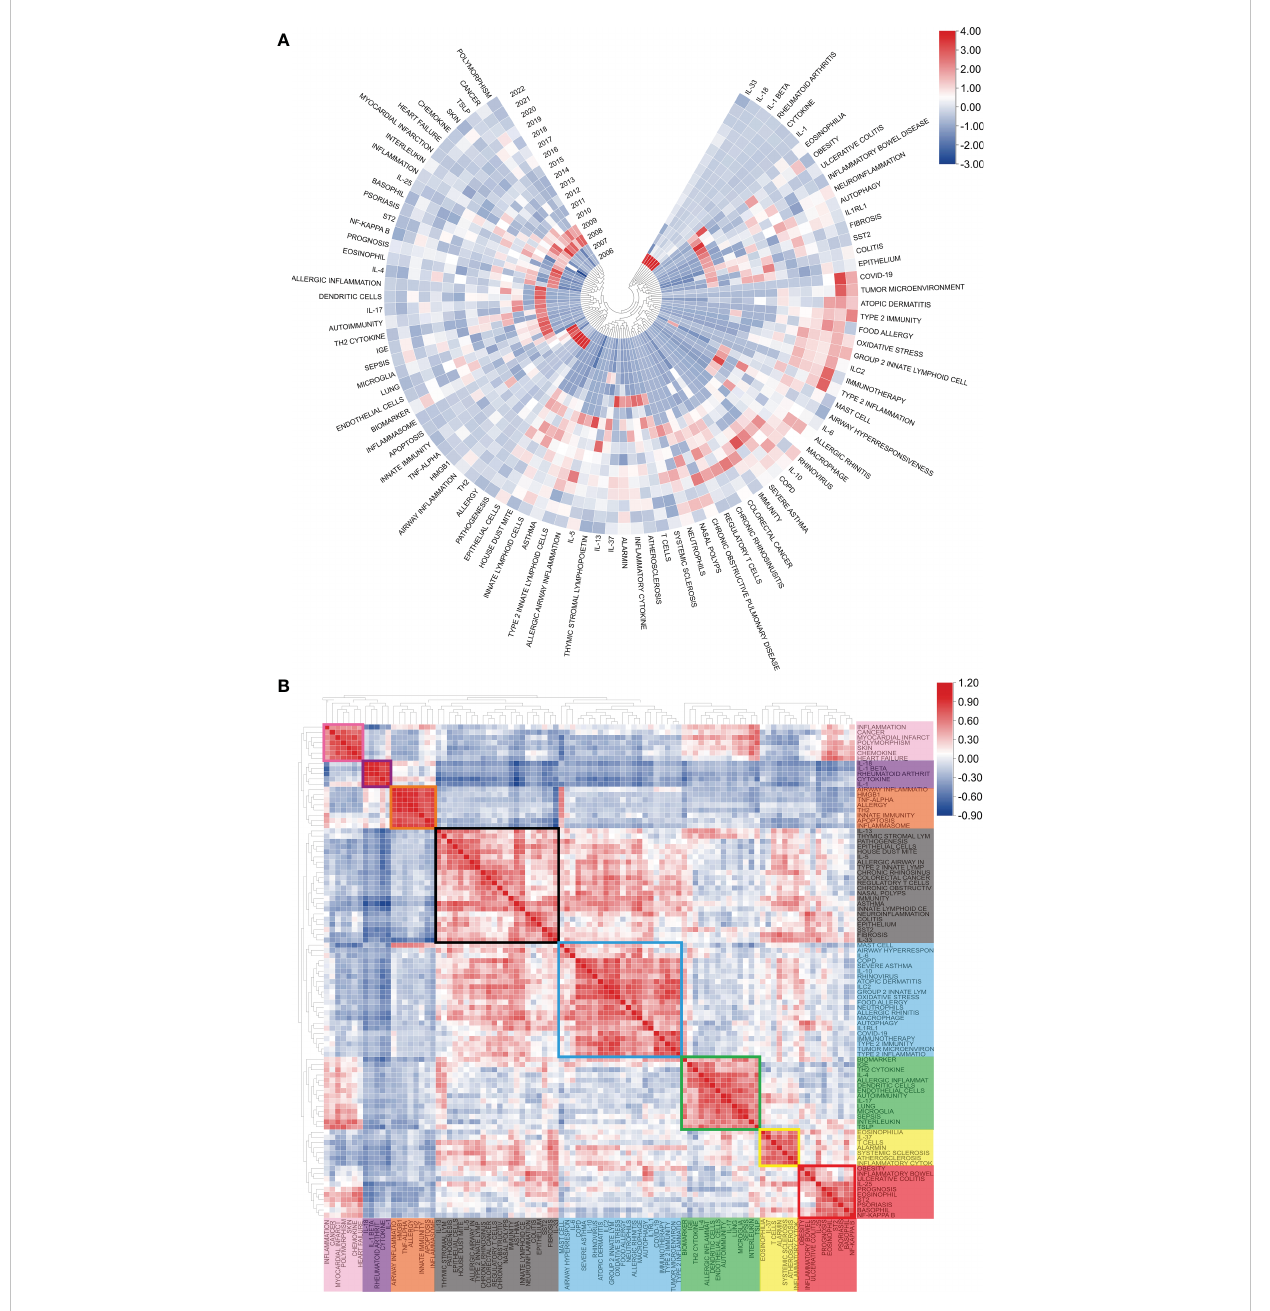
FIGURE 8 Heatmap analysis of IL-33 keywords. (A) The annual heatmap related to IL-33 research. The annual popularity of the keyword is measured as the ratio of the number of citations to the total citations in the same year. (B) Keyword relevance heatmap of IL-33. Keywords with high popularity in the same period are grouped together in a category and denoted by distinct